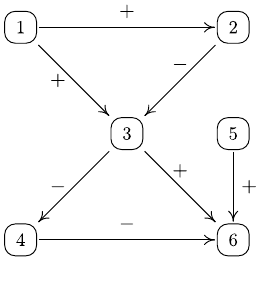
Figure 6: The structure of the causal graph used in the simulations. The causal order is un- known for the simulations. All edge weights are 1 in absolute